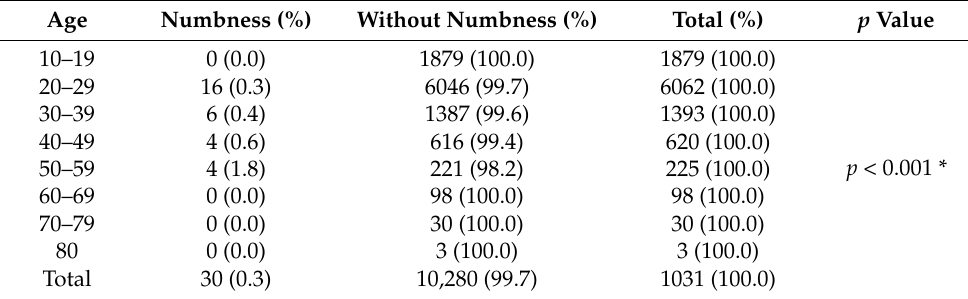
Table 12. Association between age and